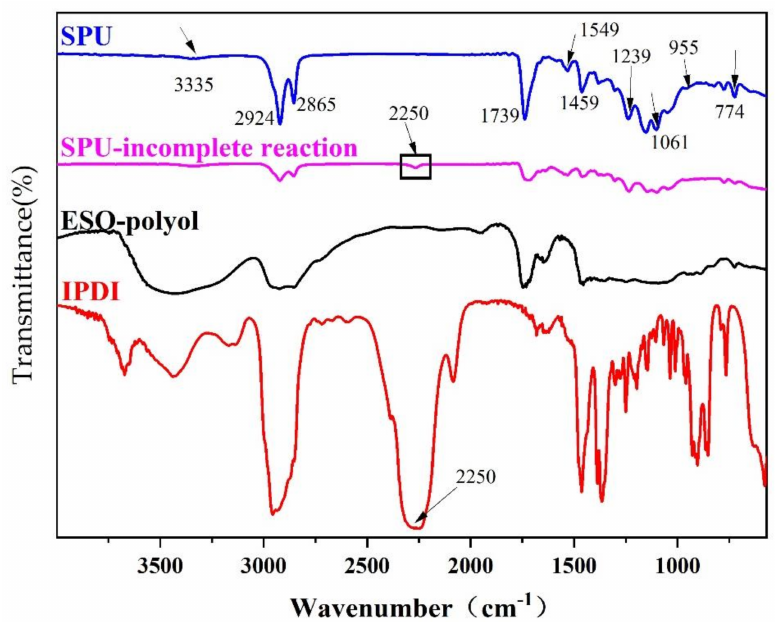
Figure 5. FT-IR spectrum of IPDI, Polyol-ESO, SPU, and SPU-incomplete